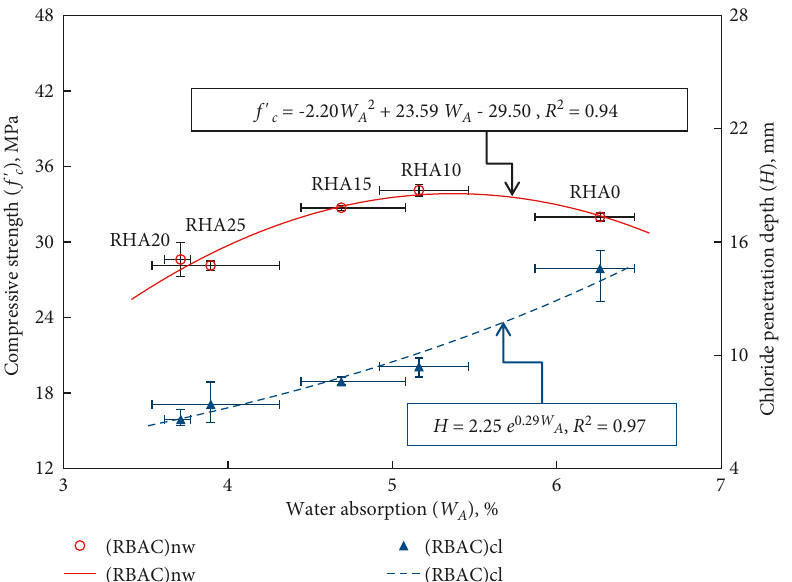
Figure 13: Relationship among the water absorption, compressive strength, and chloride penetration depth of RBAC for 90 days of immersion ((RBAC)nw � RBAC immersed in normal water, (RBAC)cl � RBAC immersed in sodium chloride